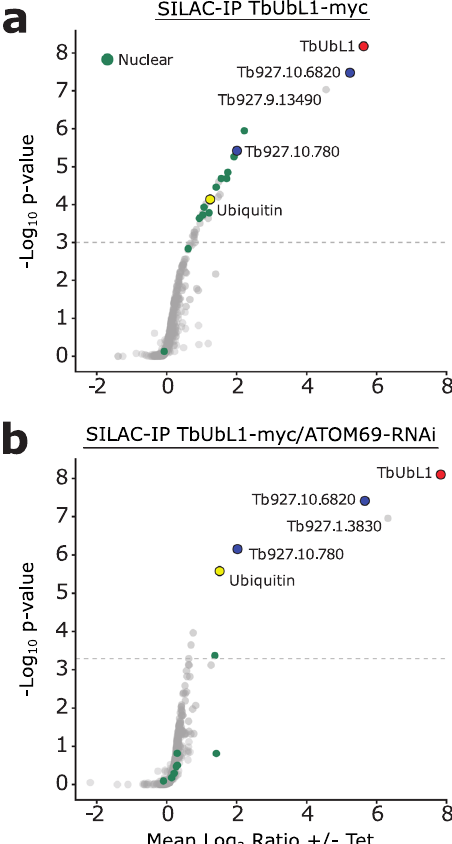
Fig. 5 SILAC-IP of TbUbL1-myc from whole cell extracts in the presence and absence of ATOM69. Stable isotope labelling by amino acids in cell culture-immunoprecipitation (SILAC-IP) experiments of a wildtype cells (TbUbL1-myc + Tet) or b an induced atypical translocase of the outer membrane 69 (ATOM69) RNAi cell line (TbUbL1-myc/ATOM69-RNAi + Tet) both expressing tetracycline inducible ubiquitin-like protein 1 (TbUbL1). Proteins shown were quanti fi ed in 3/3 independent replicates. p values were determined following the rank sum method 83 . Highlighted are the bait TbUbL1-myc (red), ubiquitin (yellow), two other proteins that are enriched in both cell lines (blue), and nuclear proteins (green). Annotation of nuclear proteins is based on Tryptag 87 or the nuclear proteome 88 . The horizontal dashed lines indicate a false discovery rate of